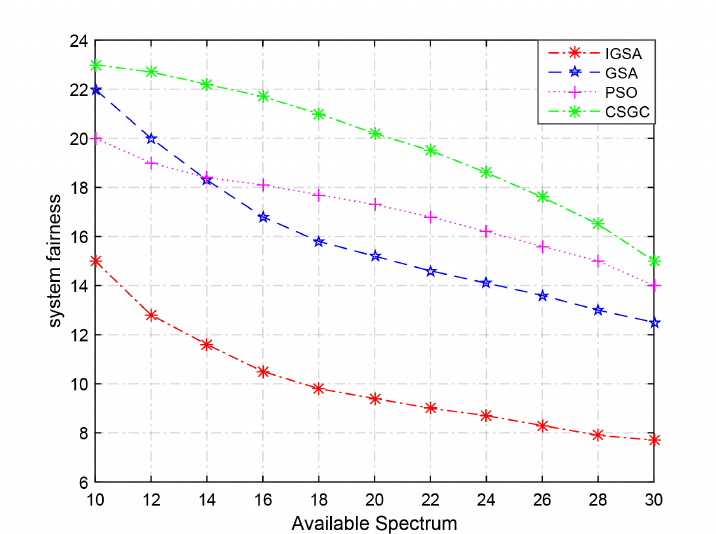
Figure 7. The system fairness trend when N =